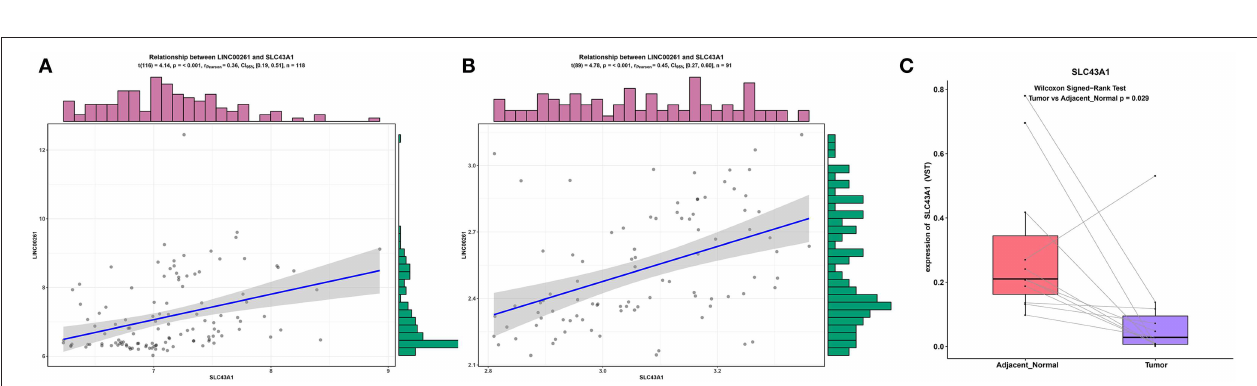
FIGURE 7 | Validation of the relationship between LINC00261 and SLC43A1. Regression analysis between the expression levels of LINC00261 and SLC43A1 in the GSE89749 (A) and GSE76297 (B) validation datasets. Violin plots of mRNA levels of SLC43A1 in the PUMCH validation dataset by using RT-PCR (C) .